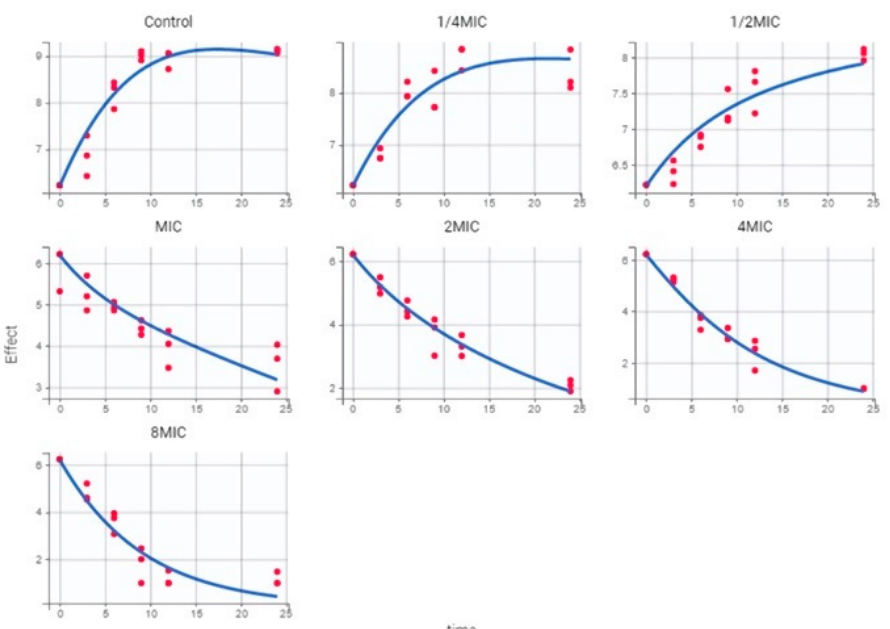
Figure 5. Model-prediction and observed of CEF against P. multocida over 24 h from the in vitro time-killing curves, i.e., observed bacterial concentration log 10 CFU/mL, IPRED: individual model predicted natural logarithm of bacterial concentration (log 10 CFU/mL).